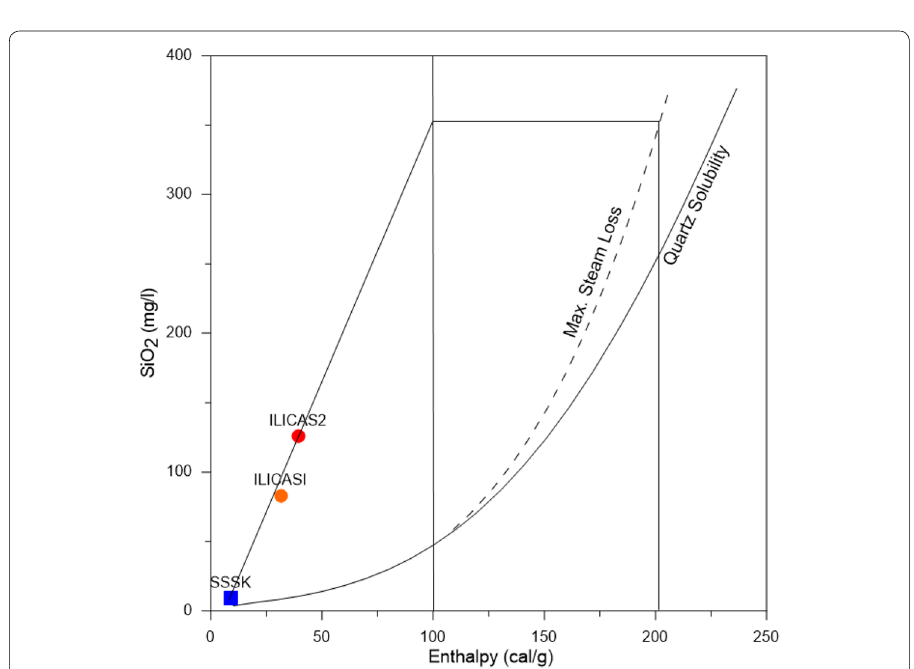
Fig. 12 Silica–enthalpy mixture model for Şavşat Geothermal